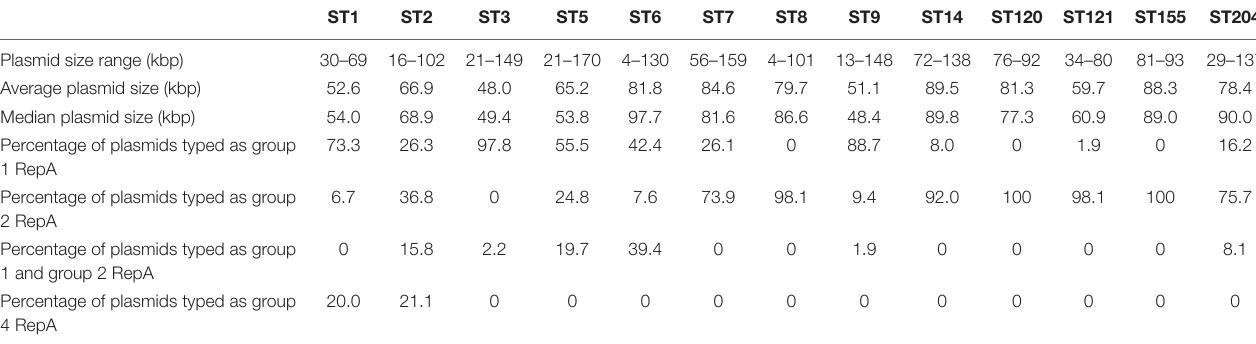
TABLE 3 | Size metrics and RepA typing for the plasmids of different Listeria monocytogenes STs*.